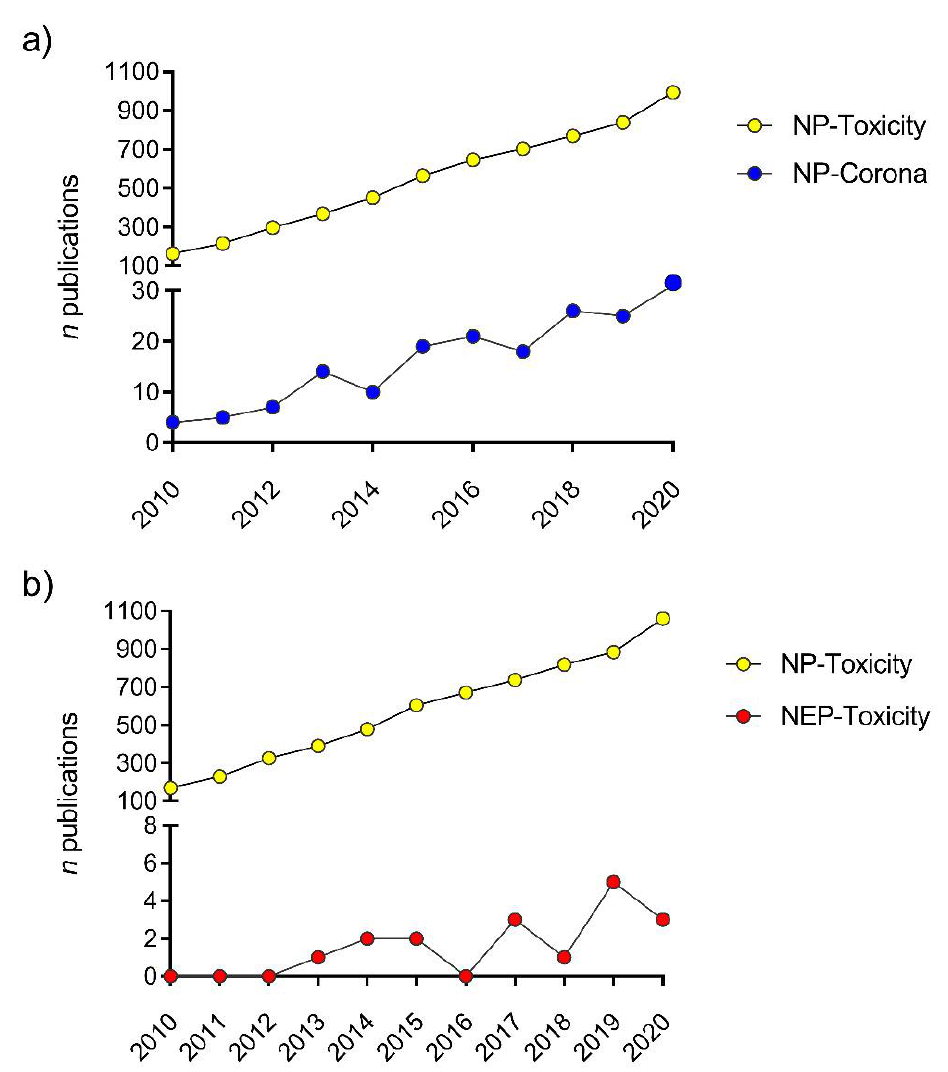
Figure 3. ( a ) The increasing relevance of NP eco- and bio-coronas (blue) in nano-ecotoxicity studies (yellow) published in the period 2010–2020. Data obtained from Scopus, search queries: ((TITLE-ABS-KEY(nanoparticles AND toxicity) AND DOCTYPE(ar) AND PUBYEAR > 1999 AND PUBYEAR < 2021 AND (LIMIT-TO (SUBJAREA,”ENVI”) OR LIMIT-TO (SUBJAREA,”AGRI”))); ((TITLE-ABS-KEY(nanoparticles AND corona) AND DOCTYPE(ar) AND PUBYEAR > 1999 AND PUBYEAR < 2021 AND (LIMIT-TO (SUBJAREA,”ENVI”) OR LIMIT-TO (SUBJAREA,”AGRI”))). ( b ) Ecotoxicity studies conducted using engineered nanoparticles/nanomaterials (yellow) and nano-enabled products (red) in the period 2010–2020. Data obtained from Scopus, search queries: ((TITLE-ABS-KEY(nanoparticles OR nanomaterials AND toxicity) AND DOCTYPE(ar) AND PUBYEAR > 1999 AND PUBYEAR < 2021) AND (LIMIT-TO (SUBJAREA,”ENVI”) OR LIMIT-TO (SUB- JAREA,”AGRI”))); ((TITLE-ABS-KEY (nano-enabled AND toxicity) AND DOCTYPE (ar) AND PUBYEAR > 1999 AND PUBYEAR < 2021 AND (LIMIT-TO (SUBJAREA,”ENVI”) OR LIMIT-TO